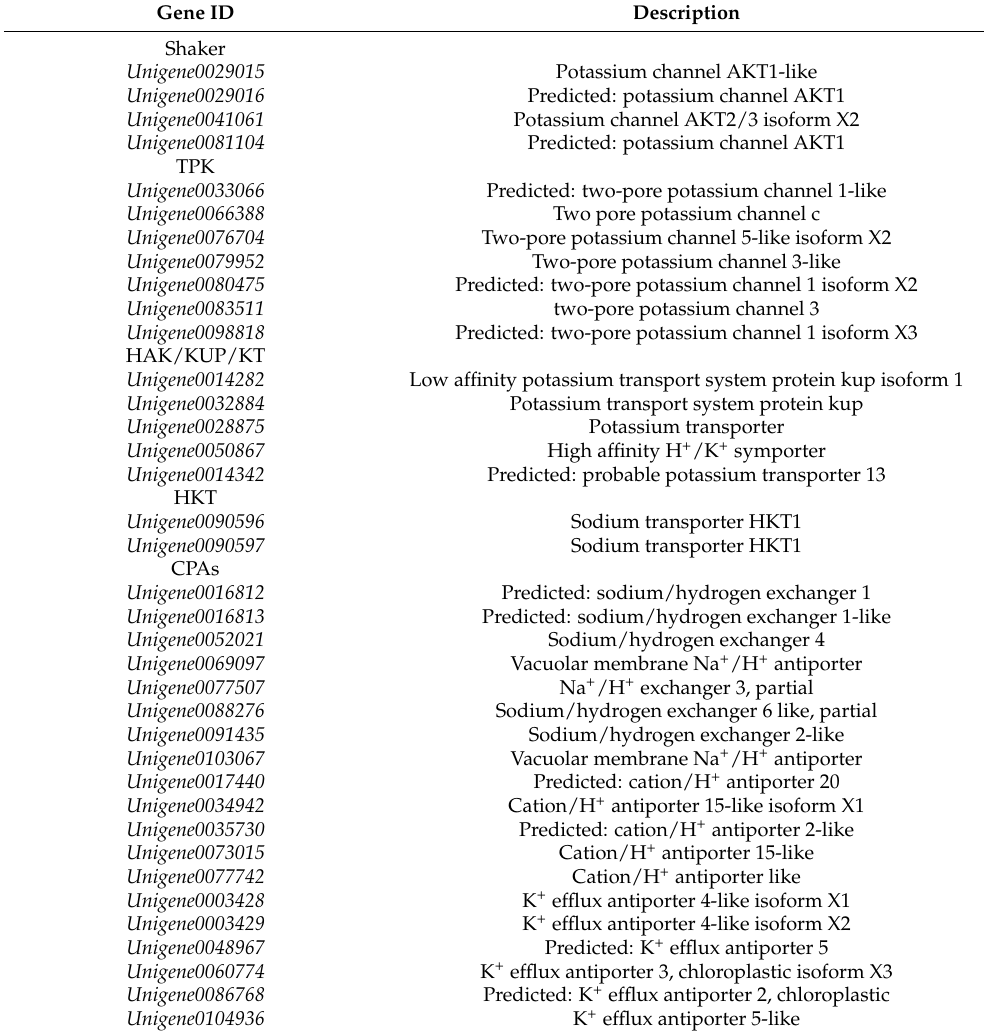
Table 2. K + channel- and transporter-related